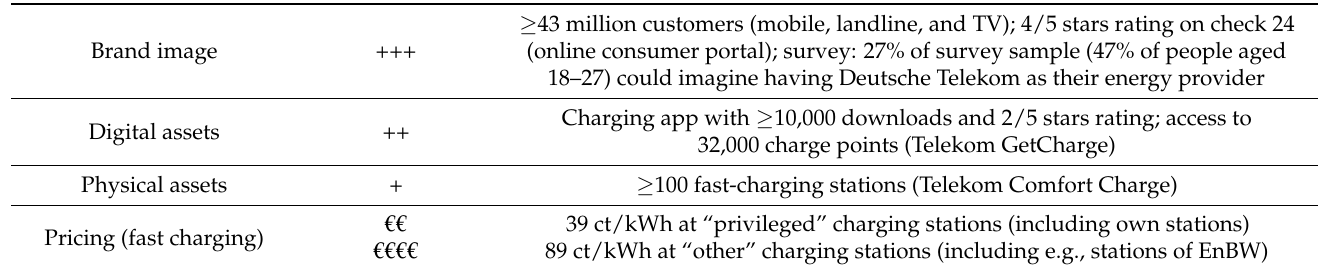
Table 7. Analysis of Deutsche Telekom